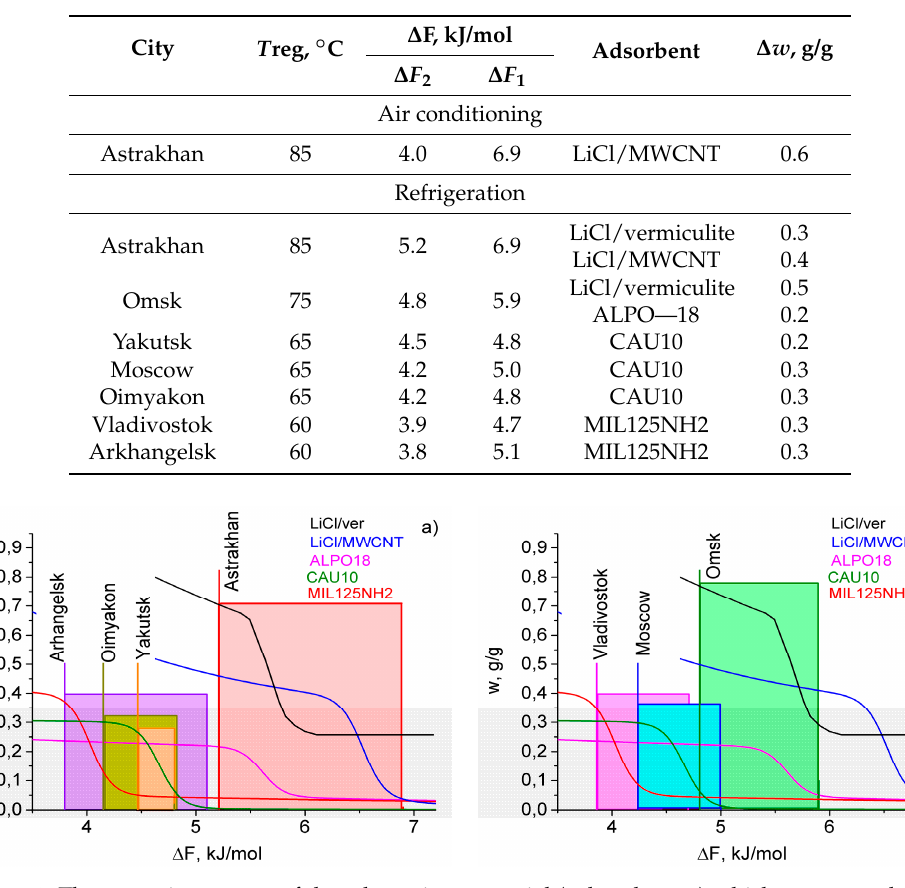
Figure 4. The operating ranges of the adsorption potential (colored areas) which correspond to the refrigeration cycle ( T ev = 3 °C, T con = T ads = T d.max) for the climatic zones analyzed and the universal curves of water adsorption on the adsorbents, optimal for each zone (Table 1). The refrigerant is water vapor.